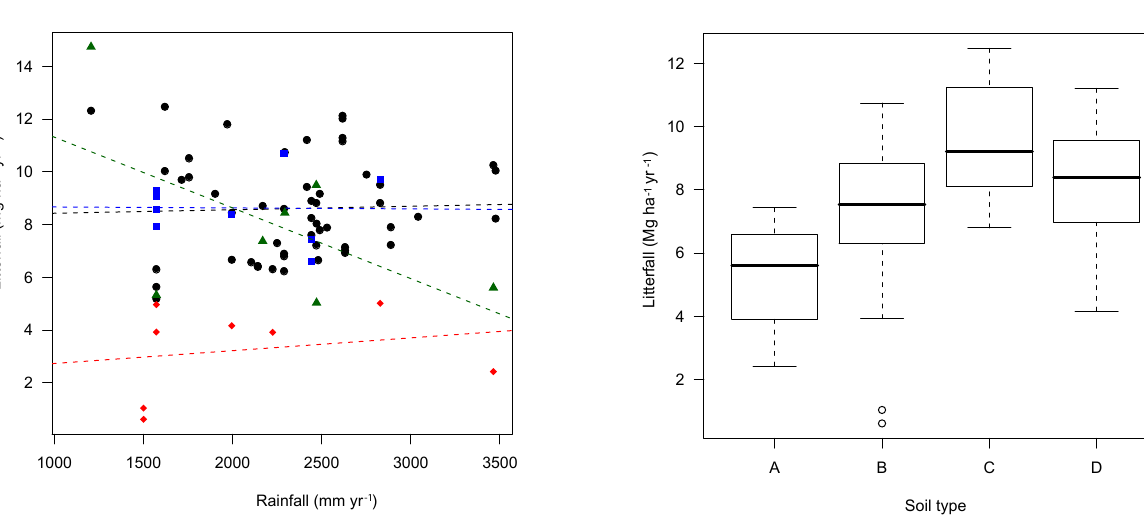
Fig. 3. Regional variation in litterfall. Variation in total litterfall across the sites (a) , only in old-growth forests (b) , variation in leaf fall (c) and variation in allocation into reproductive organs (d) . All figures are in Mgha − 1 yr − 1 .